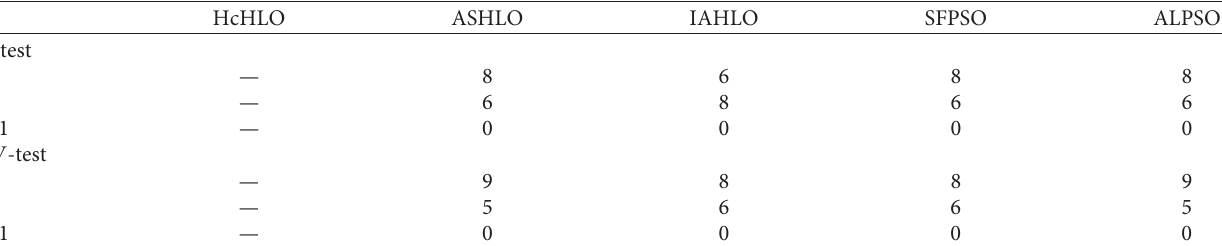
Table 2: The summary results of the t -test and W -test on the benchmark functions.